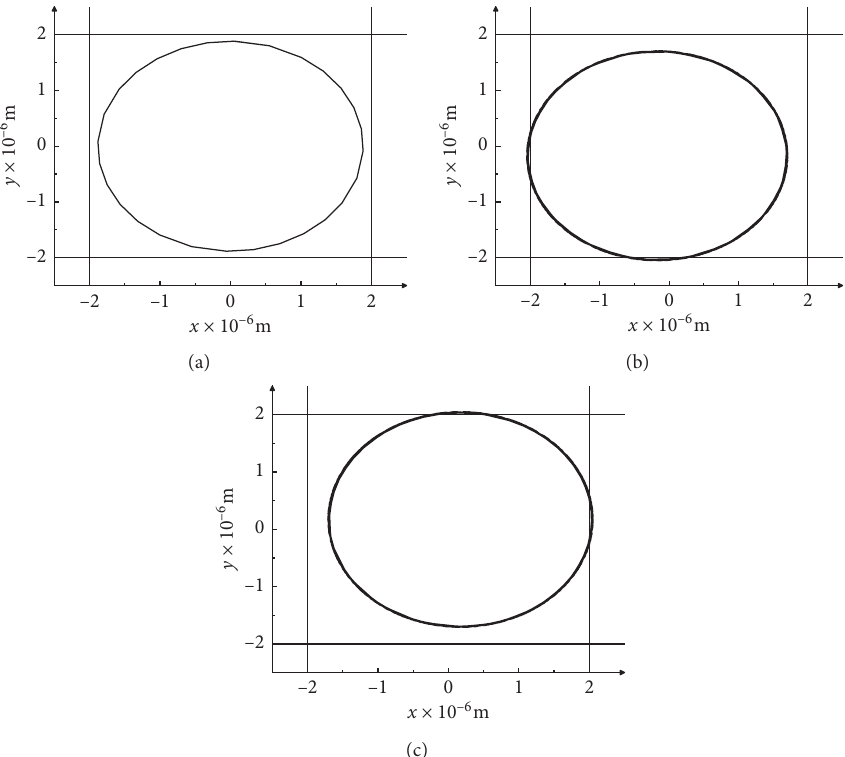
Figure 8: Orbit of spindle center. (a) No static eccentricity. (b) Static eccentricity at 45 ° . (c) Static eccentricity at 225 ° .